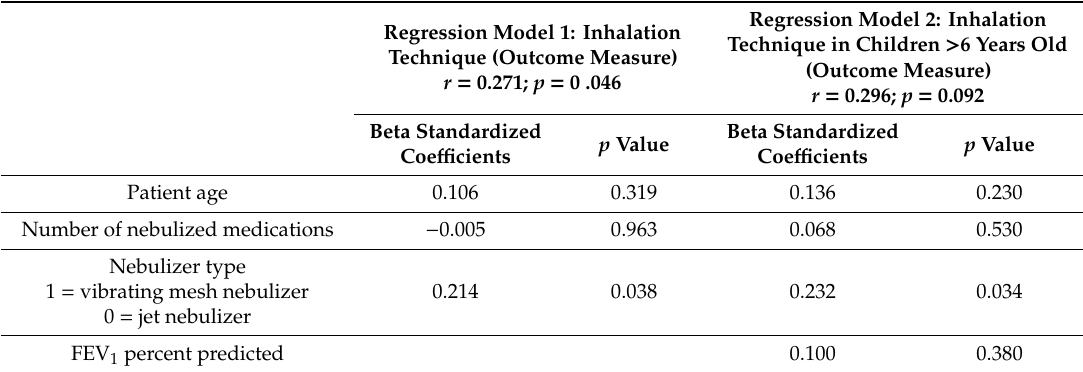
Table 2. Associations between age, number of nebulized medications, nebulizer type, FEV 1 percent predicted (for group aged > 6 years) with patient inhalation technique score.